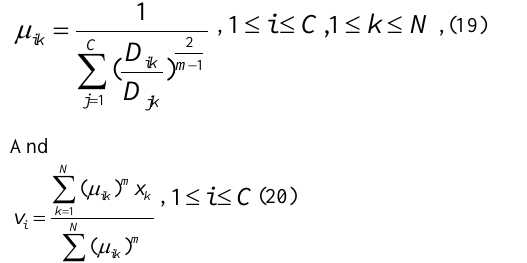
Figure 2. Unsupervised classification